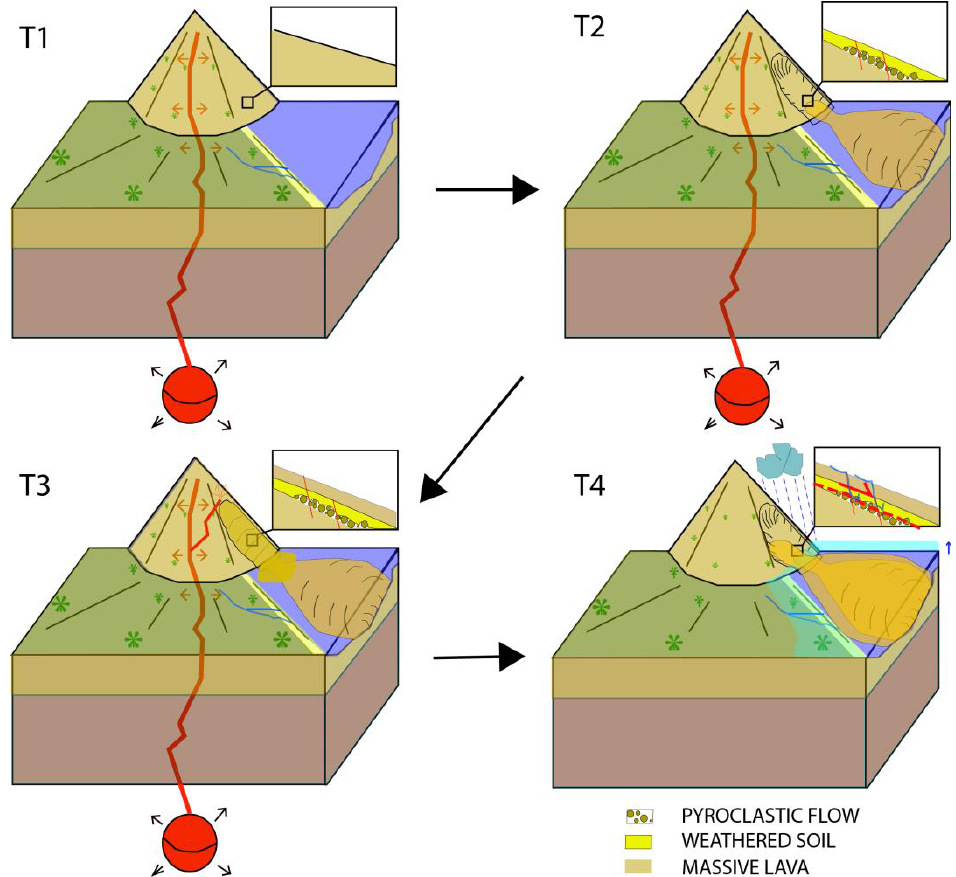
Figure 1. Complex evolution of volcanic edifices and locations of deep weakness zone, ( T1 ) Young volcanic edifice composed of massive lavas, ( T2 ) Volcanic edifice after a giant landslide caused by a volcanic process, where pyroclastic flows, as well as soil and lava weathering, occur, ( T3 ) Filling of the landslide scar by thick volcanic lavas above the pyroclastic debris and the weathered soils, ( T4 ) Deep rooting of the landslide into the weakness zone favored by meteoric water infiltration and/or sea level loading in the case of an old and complex volcano and/or the presence of deeply incised